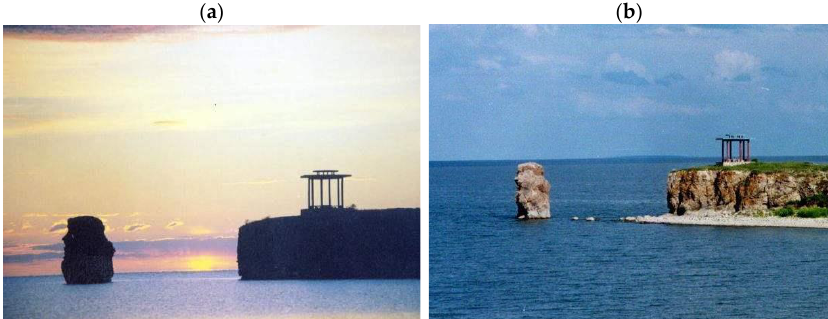
Figure 5. Photographs of Hulun Lake taken at the same location at different times: ( a ) summer of 2000, and ( b ) summer of 2007.